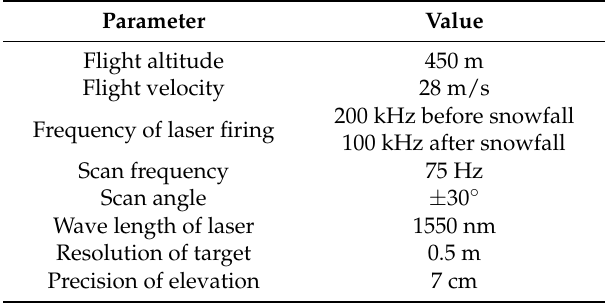
Table 1. Flight condition and LiDAR device configuration (SAKURA